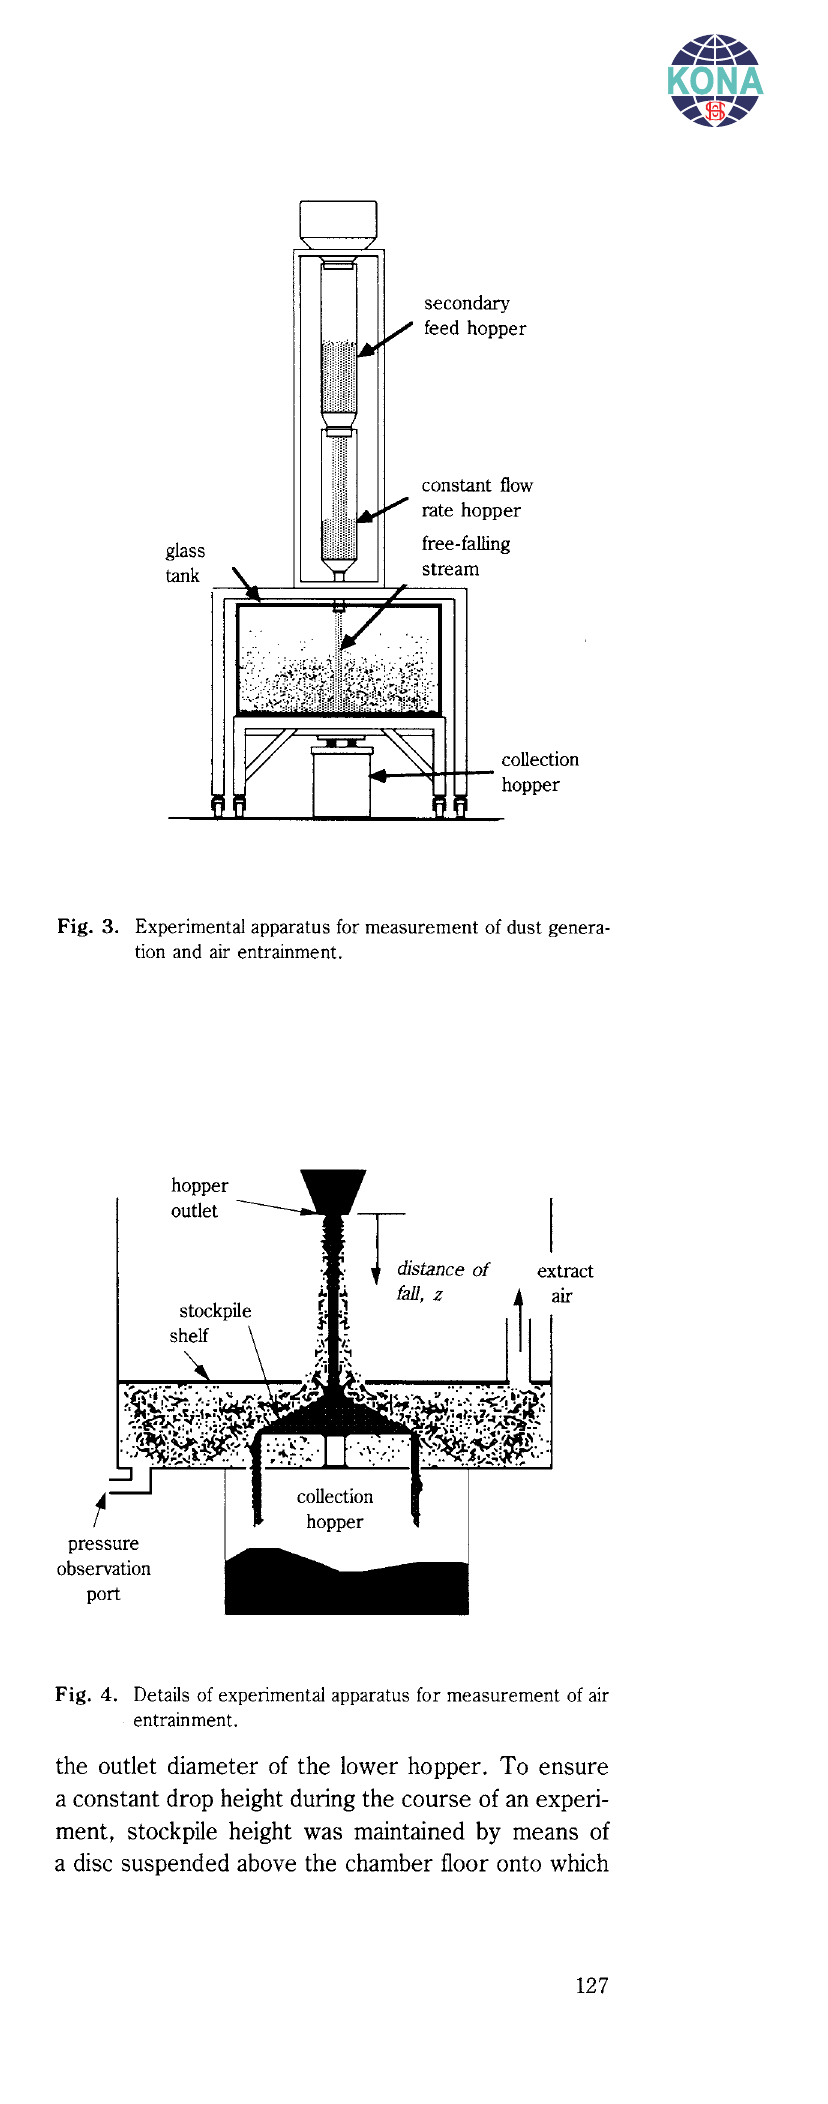
Fig. 4. Details of experimental apparatus for measurement of air